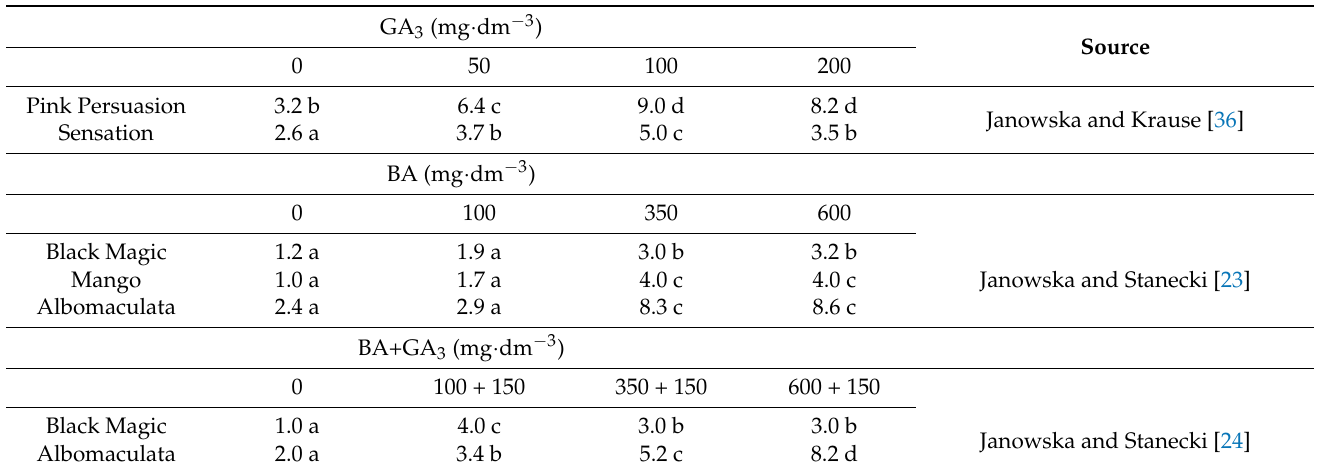
Table 1. Flowering (number of inflorescences per 1 rhizome) of Zantedeschia cultivars after application of growth regulators. Means followed by the same letter column-wise and row-wise do not differ significantly at α =